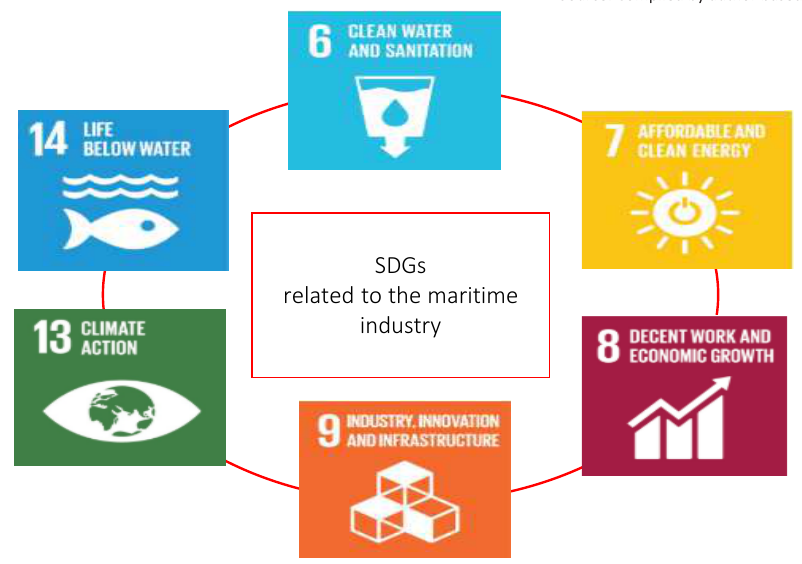
Figure 14. Sustainable development goals related to the maritime